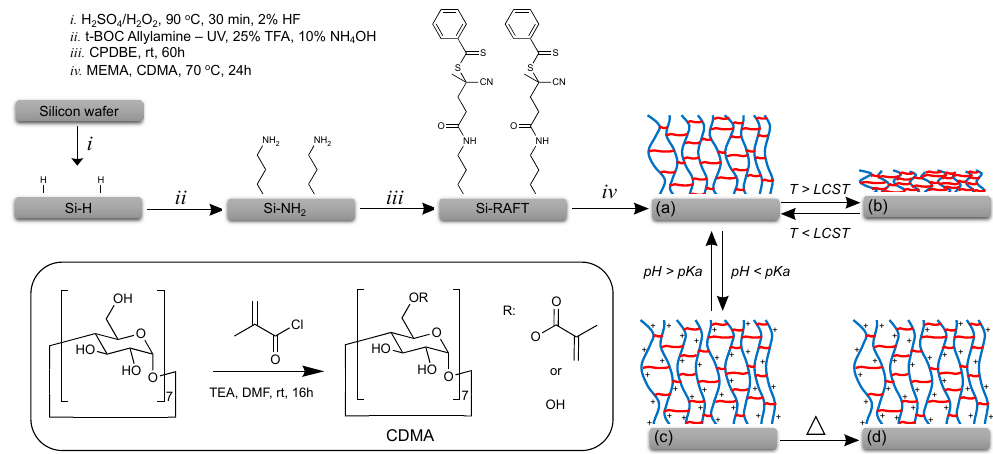
Scheme 1. Synthesis of β -cyclodextrin methacrylate (CDMA) and schematic procedure for fabricating poly(2- N -morpholinoethyl methacrylate) (PMEMA) brush-gels: ( a ) PMEMA brush-gels: capture and release; ( b ) collapsed-PMEMA brush-gels: no capture and no release; ( c ) cationic PMEMA brush-gels: release; ( d ) cationic PMEMA brush-gels: fast